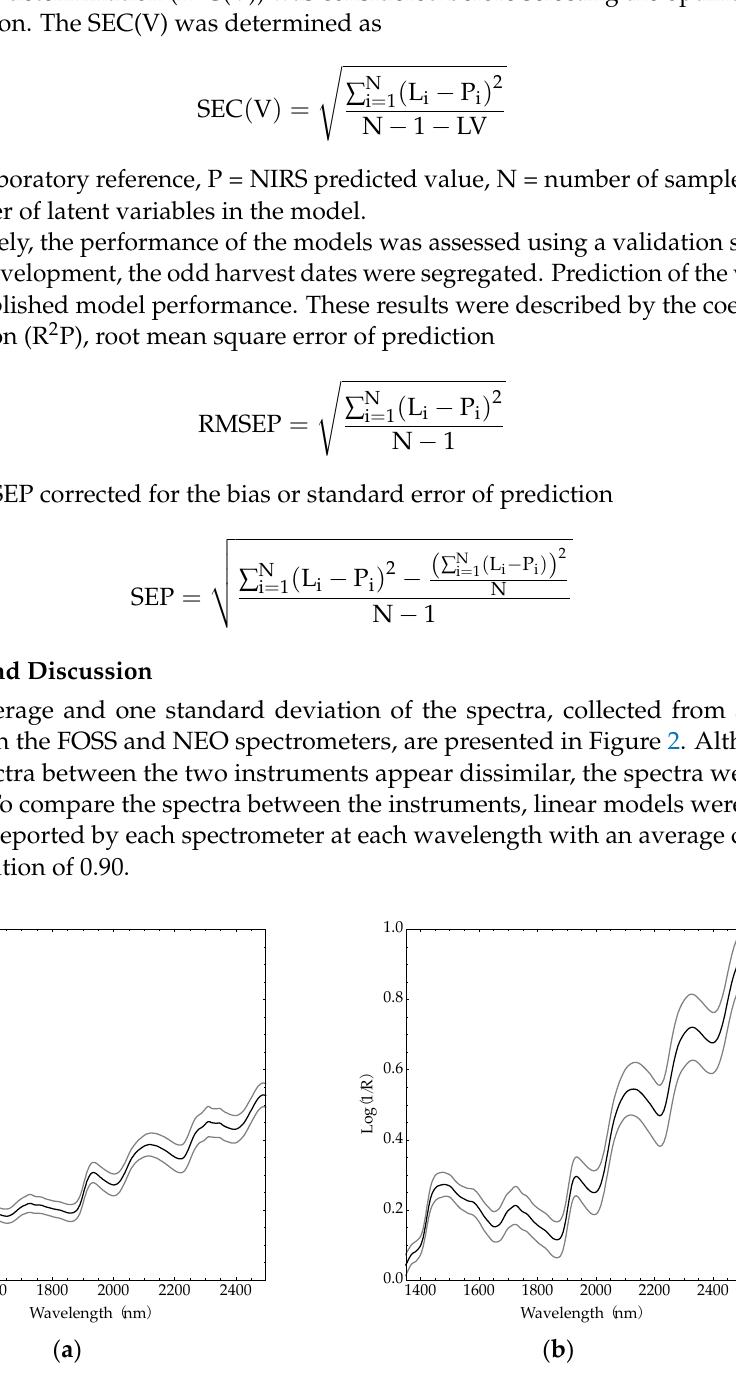
Figure 2. ( a ) Mean and standard deviation of spectra collected from 384 dried and ground forage samples collected with the FOSS NIRSystems 6500; ( b ) Mean and standard deviation of spectra collected from 384 dried and ground forage samples collected with the NeoSpec-Scanner.